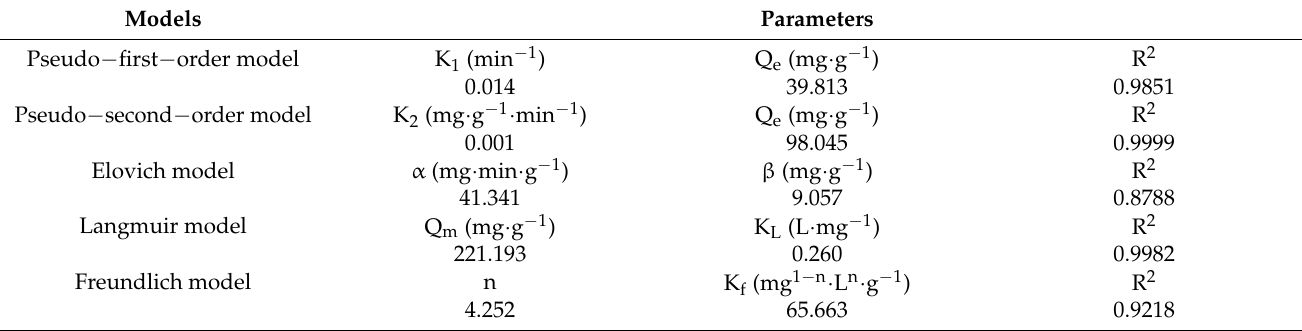
Table 2. The parameters of kinetic and thermodynamics models for the adsorption of V(V)